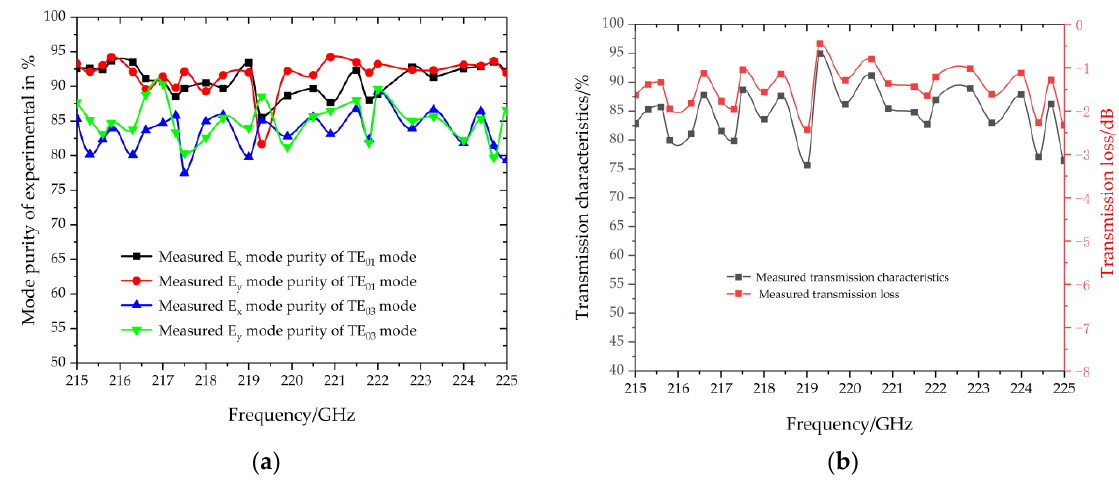
Figure 8. ( a ) The calculation result of the mode purity of the electric field component at the input and output of the mode converter, and ( b ) The experimental results of transmission loss of mode converter.